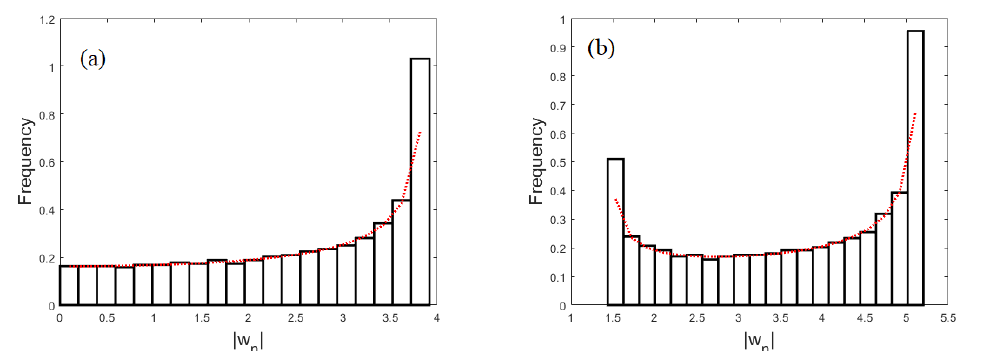
Figure 7. Histogram of the radii | w n | of the Horadam sequence the terms ( w n ) 1000 r 1 = r 2 = 1 when ( a ) x 1 = π , x 2 = e 2 and a = 1 + 1/3 i , b = 1.5 a exp ( π ( x 1 + x 2 )) ( | A | = | B | ); 5 4 √ 2 ( b ) x 1 = , x 2 = e and a = 2 + 2/3 i , b = 3 + i ( | A | (cid:54) = | B | ). The probability densities f r given by 3 15 Formulae (22) and (23) are shown by a dotted line. Parameters correspond to Figures 1b and